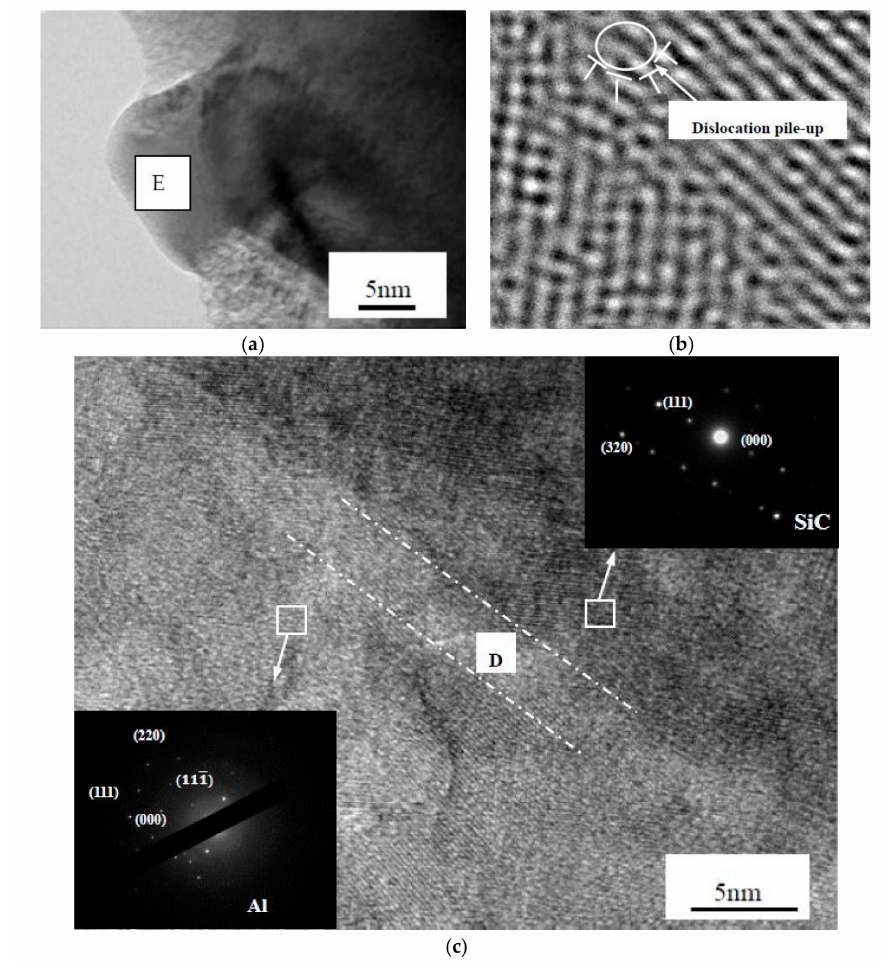
Figure 7. ( a ) TEM micrograph of AA6061 / 1 vol.% N-SiCp sintered at 550 ◦ C and 4.5 GPa, ( b ) IFFT image of zone D in Figure 7c, ( c ) HRTEM image of zone E in Figure